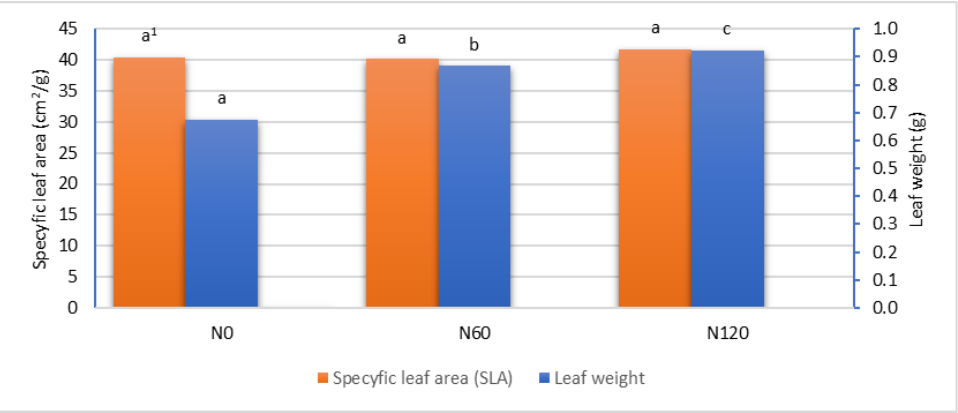
Figure 7. Effect of nitrogen fertilization on the leaf surface (cm 2 ) and SLW (leaf area per fresh weight) of sour cherries, average for 2012–2013. 1 means that the same letters are not significantly different at α = 0.05 (Duncan’s